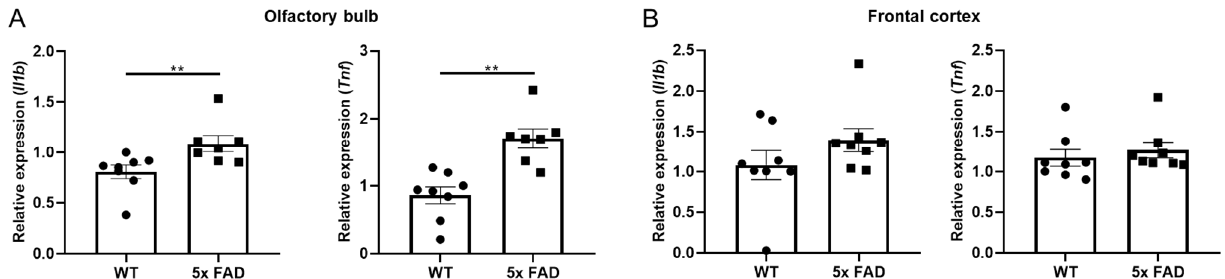
Figure 2. Increased pro-inflammatory cytokines in the OB but not FC of 2 mo 5 × FAD male mice. Il1b and Tnf mRNA levels were measured by qPCR in the OB and FC ( n = 7–8 per group). ( A ) Il1b and Tnf were more abundant in the OB of 5 × FAD mice (square dots) than WT littermates (circle dots); ( B ) Il1b and Tnf in the FC did not show genotypic differences. Data expressed as mean ± SEM; ** p < 0.01 (Mann-Whitney test).